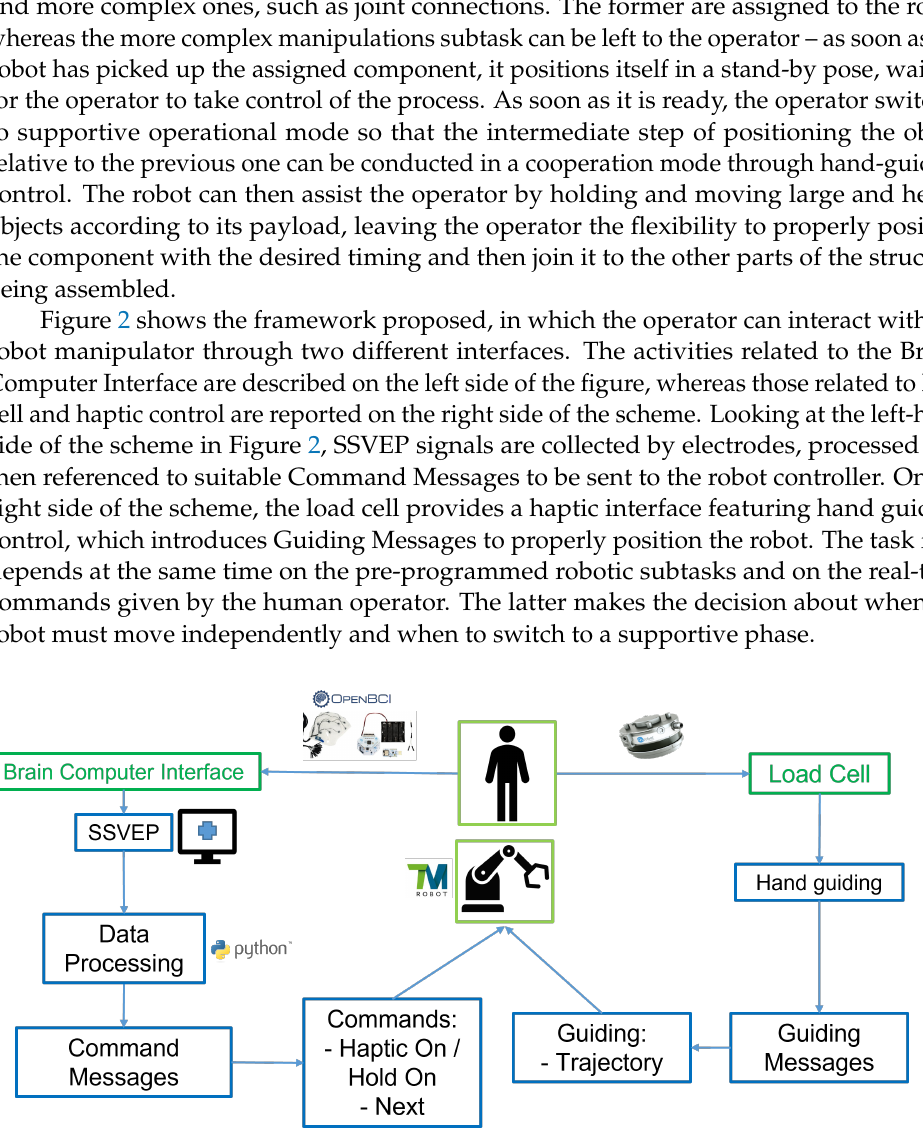
Figure 2. BCI-SSVEP with Load Cell sensor